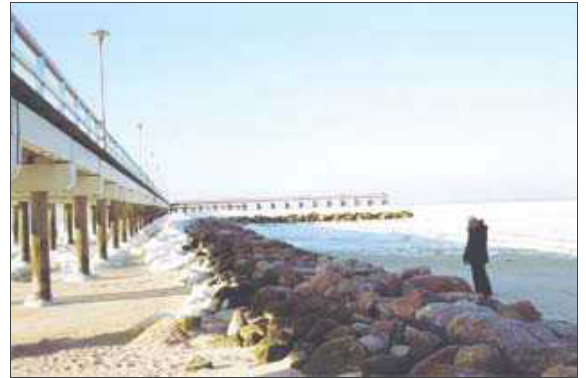
Fig. 6. Sea bridge and pier – potential wave powerstations Fig. 7. Windpowerstation farms in the sea can disturb old tradition of sundown